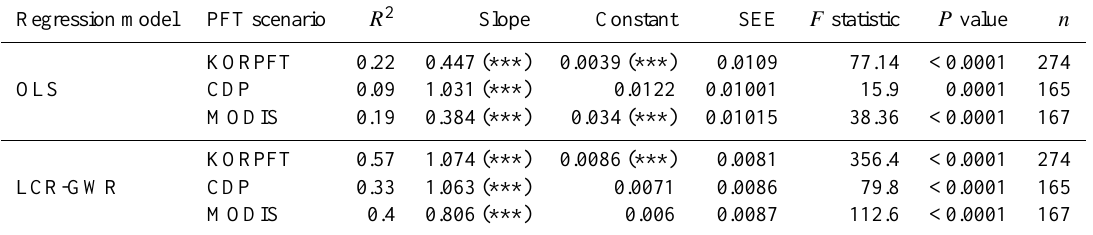
Table 5. Evaluation summary for the global OLS and LCR-GWR models of delta O 3 for three PFT scenarios. The significance levels of the parameters based on the t statistic are (***) for p value <0.001, (**) for 0.001–0.01, (*) for 0.01–0.05, ( • ) for 0.05–0.1, and ( ) for >0.1. SEE: standard error of